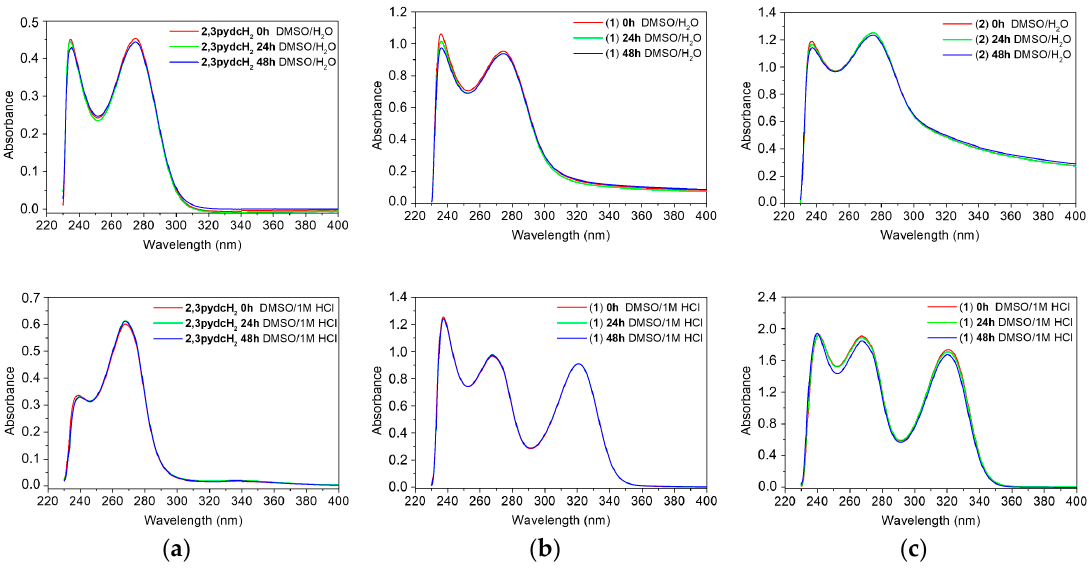
Figure 10. Time-dependent (0 h, 24 h and 48 h) stability studies on: ( a ) 2,3pydcH 2 , ( b ) complex 1 , ( c ) complex 2 in DMSO/H 2 O 1:50 ( v/v ) (top) and DMSO/1M HCl 1:50 ( v/v ) (bottom) solutions monitored by UV-Vis absorption spectra.